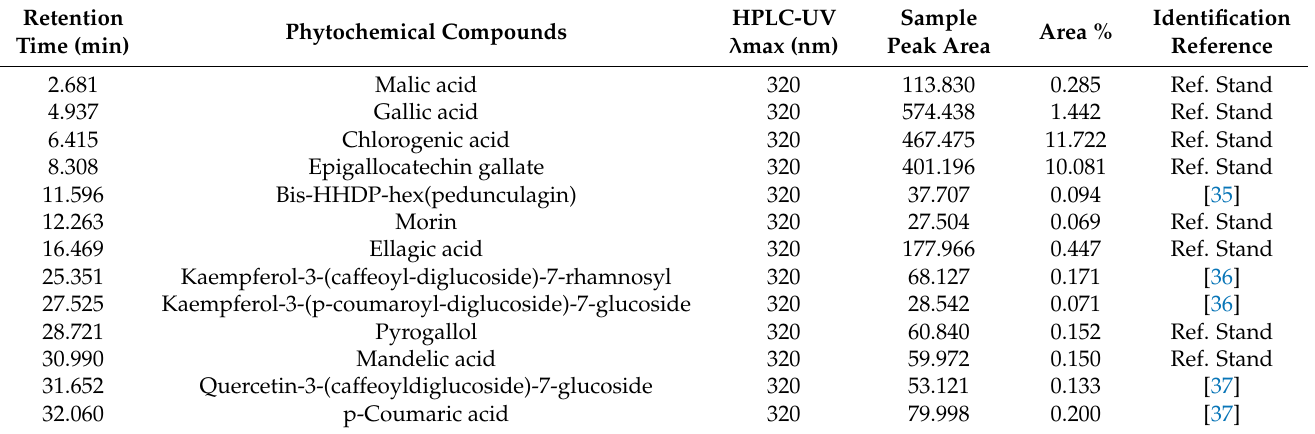
Table 1. Identification of phenolic compounds through HPLC-DAD in flower methanolic extract of P. hysterophorous